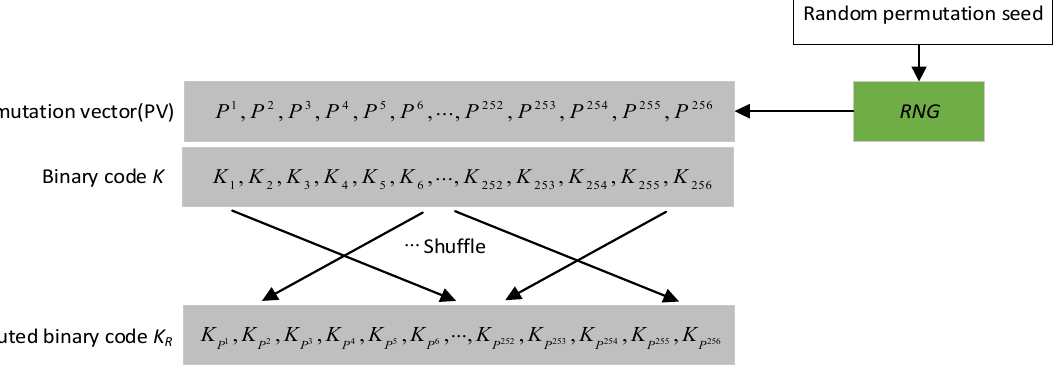
Figure 5. Illustration of the random permutation where the length of binary code is 256.